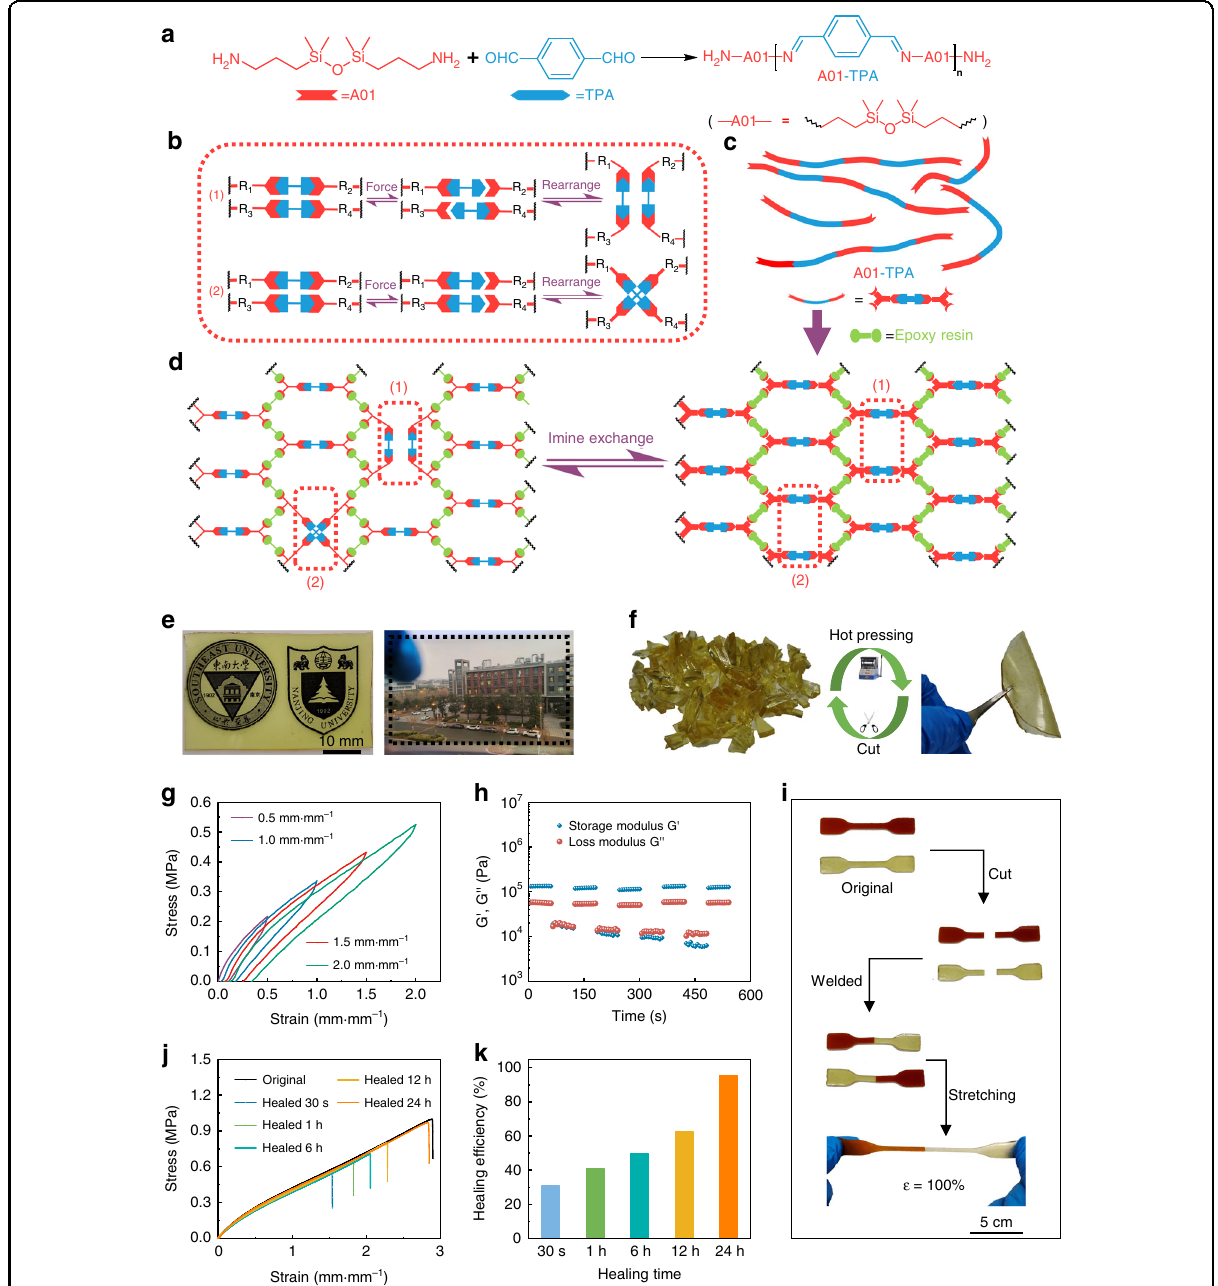
Fig. 2 The fabrication of ATPA-EP and its mechanical and self-healing performance. a Synthesis route of A01-TPA and its structure. b Associative exchange mechanisms of epoxy-polyimine CAN. c Simpli fi ed schematic of A01-TPA. d The crosslinking dynamic ATPA-EP network. e The as-prepared transparent ATPA-EP fi lm and f its reprocessability. g Cyclic loading – unloading curves of ATPA-EP from 50 to 200% strain without relaxing time. h Continuous step strain measurements of ATPA-EP at 25 °C. i Photographs depicting the macroscopic cutting – welding – stretching procedure of two ATPA-EP samples with different colors at room temperature. j Typical stress – strain curves for the cut ATPA-EP fi lms that were healed under different time scales. k The self-healing ef fi ciencies of ATPA-EP fi lms under different time